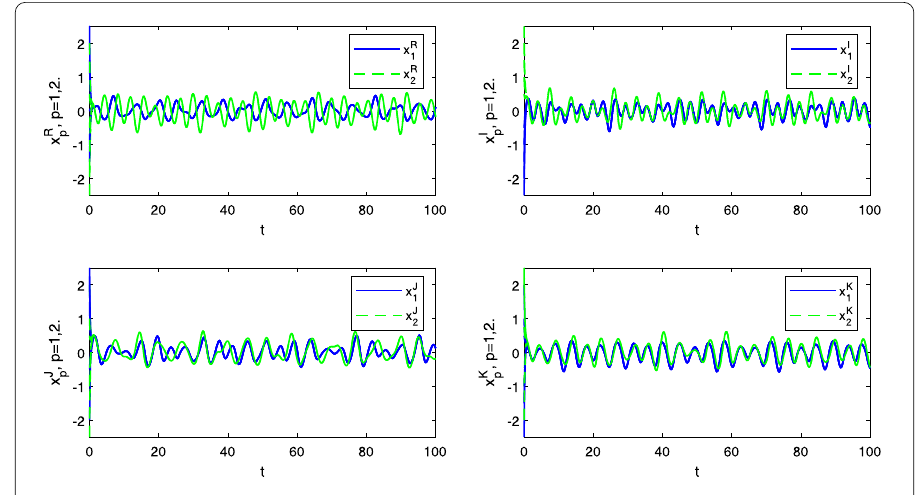
Figure 1 Transient states of four parts of QVNN (23) in Example